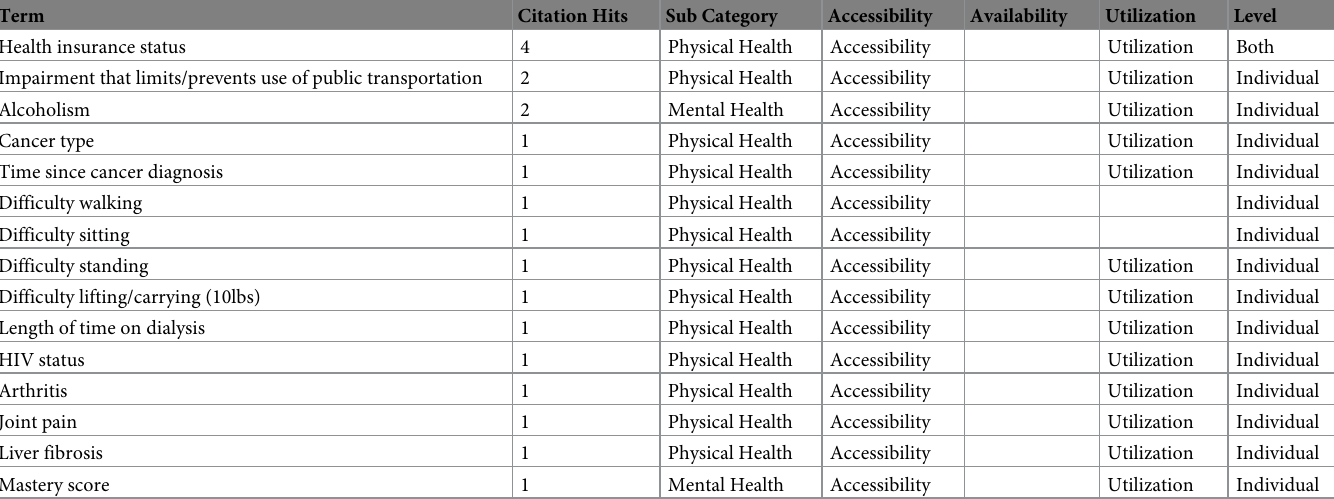
Table 5. Health-related risk factors mapped to the dimensions of food security.